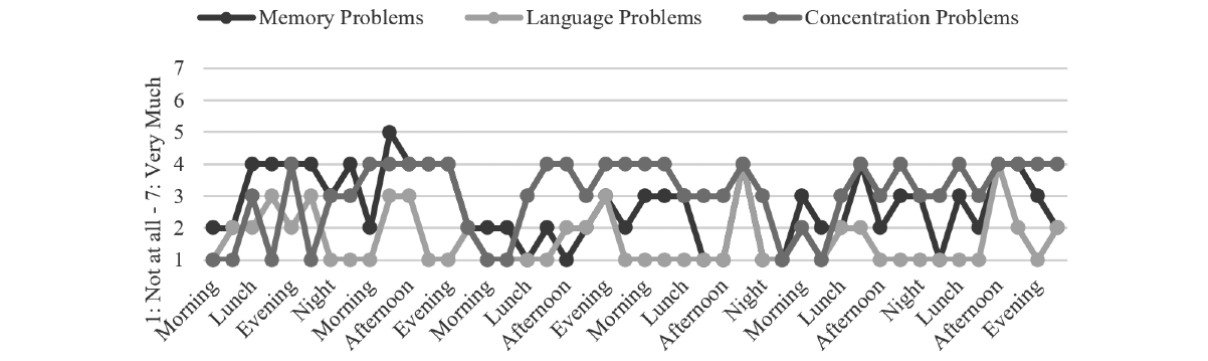
Figure 3. Person 2: subjectively experienced cognitive